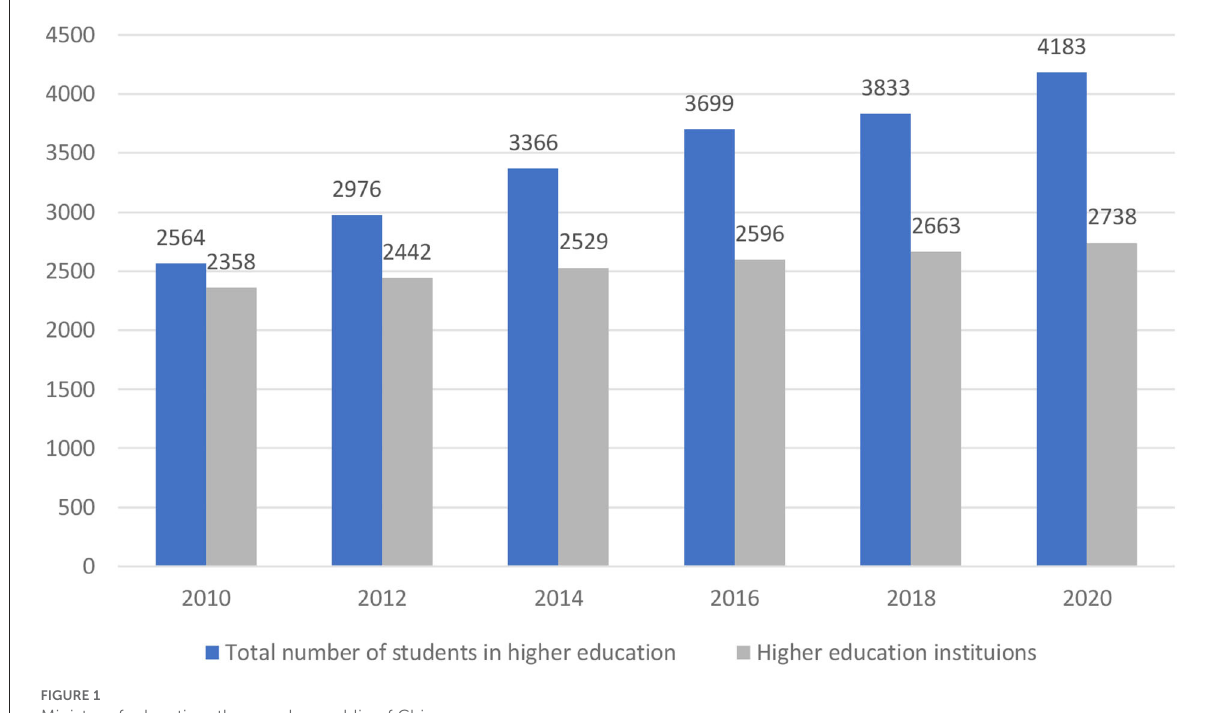
FIGURE1 Ministry of education, the people republic of China.